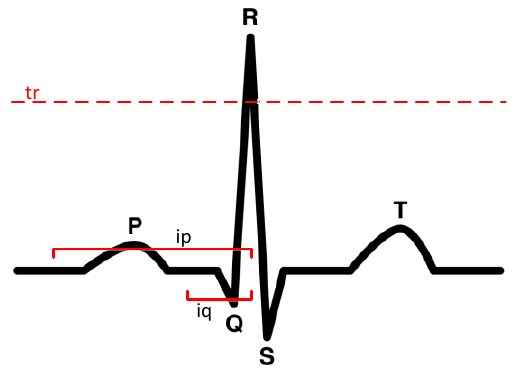
Figure 7. Waves P,T and complex